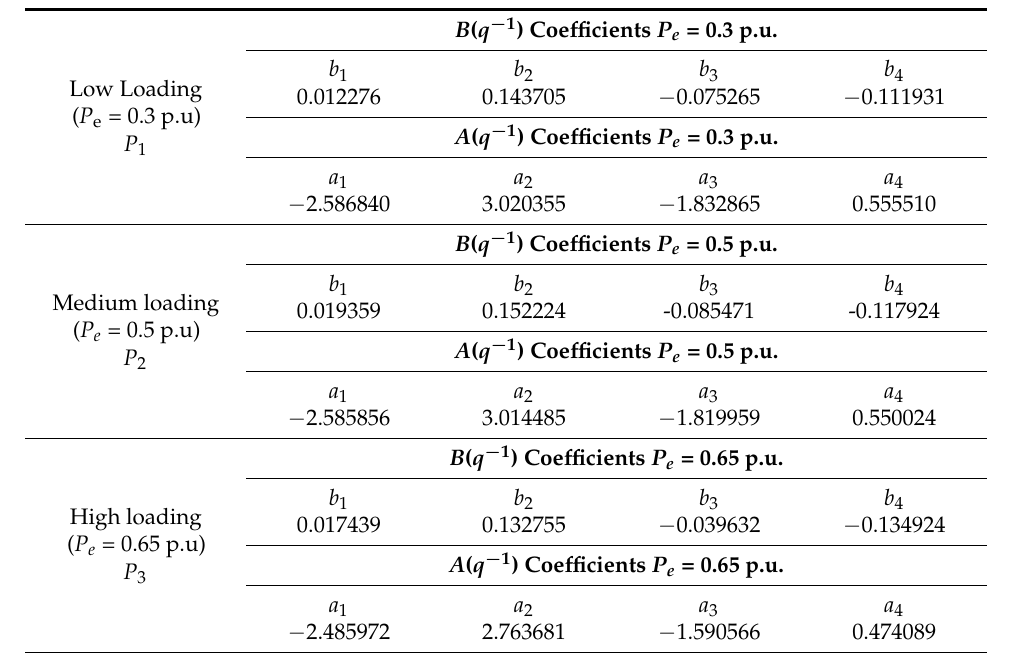
Figure 5. Frequency response of active power deviation and PRBS signals. Table 2. Identified Local Models Parameters, sampling time T S = 0.06